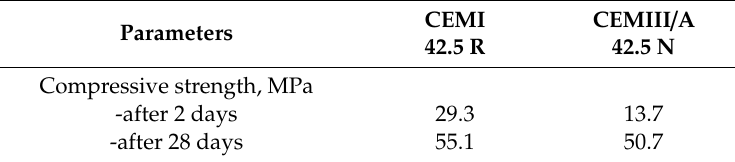
Table 3. Mechanical characteristics of CEM I and CEM III